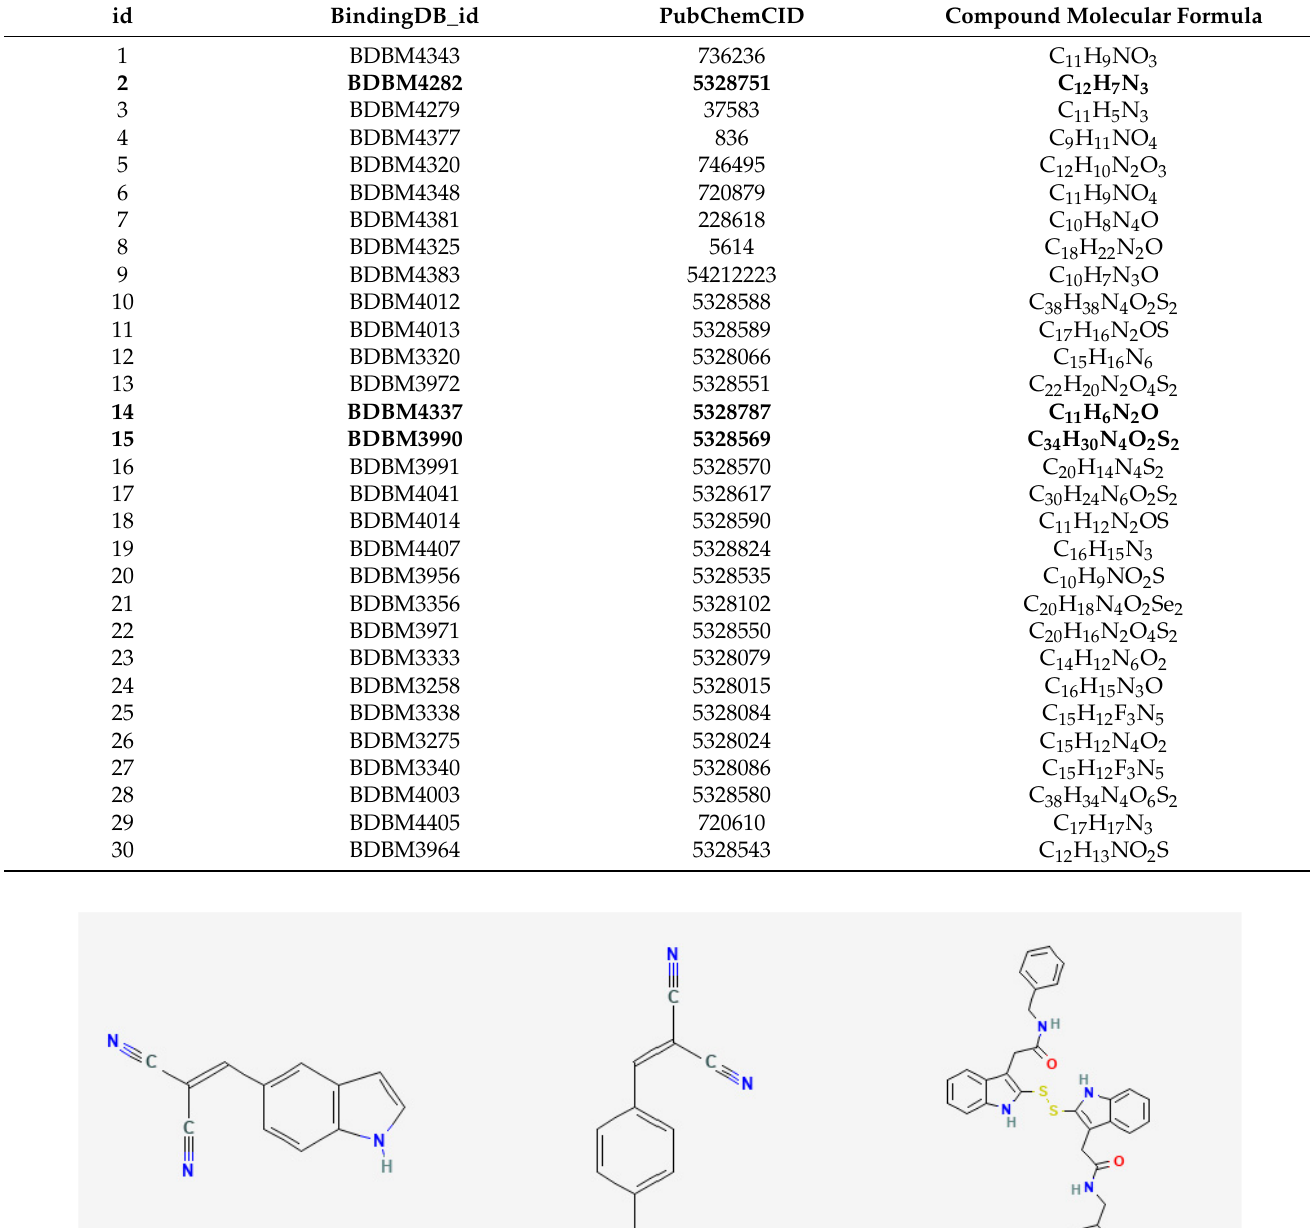
Table 6. The first 30 compounds known to interact with EGF proteins.